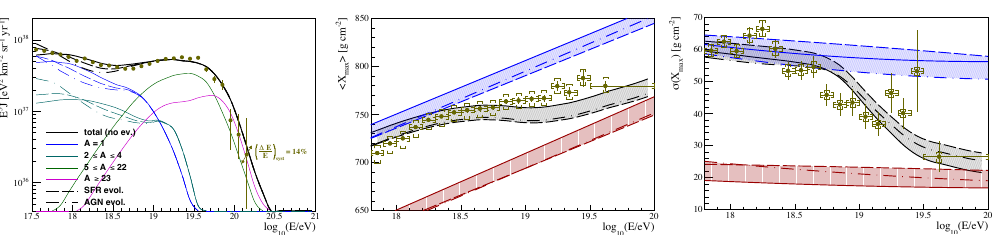
Figure 1. Comparison of the flux (left panel), elongation rate (central panel) and its root mean square (right panel) as observed by Auger and computed assuming the model with two classes of di ff erent extragalactic sources [10].